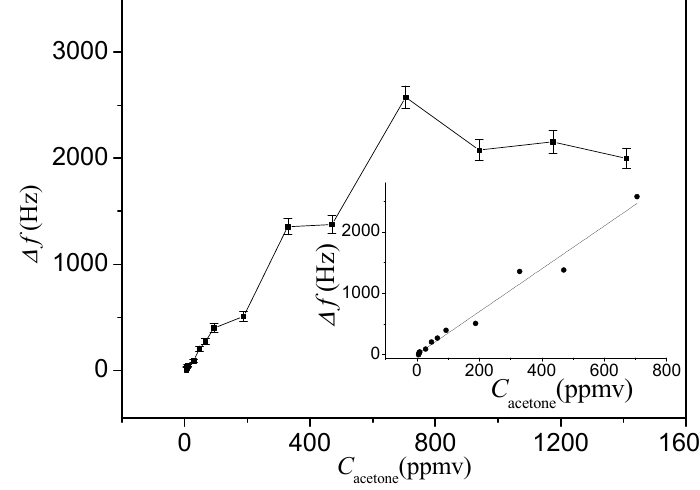
Figure 3. The relationship between the response frequency shift and acetone concentration on the